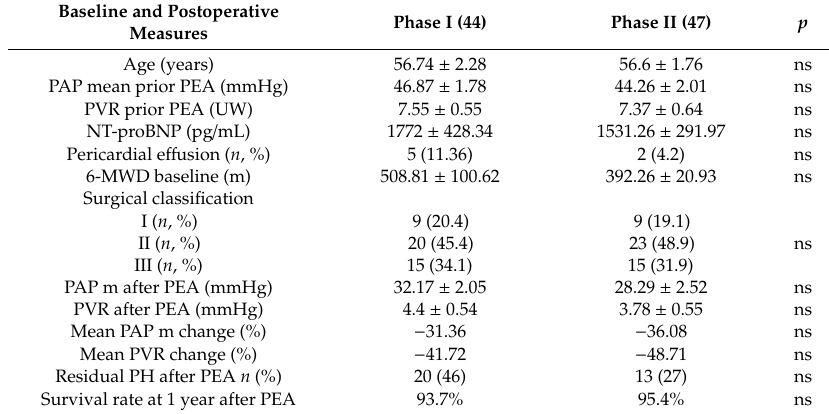
Table 2. Baseline and postoperative measures in operated patients.